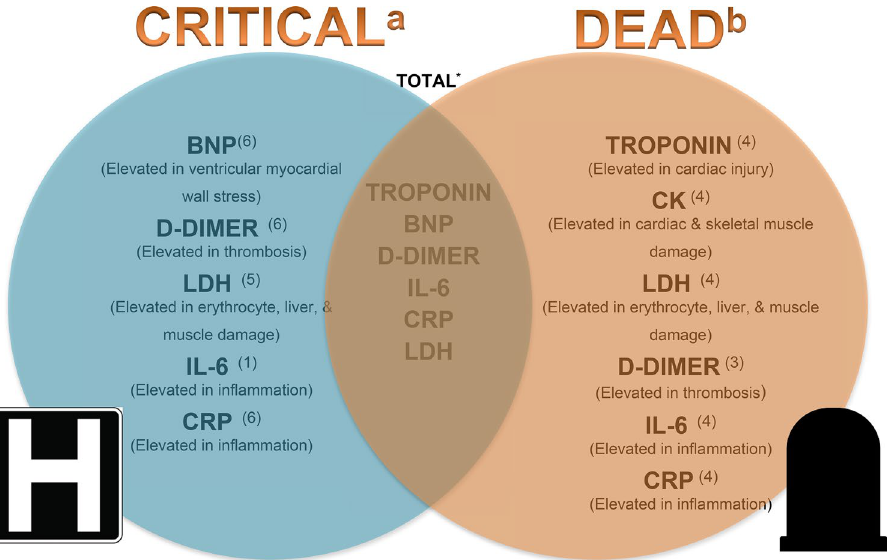
Figure 4. Biomarkers in COVID-19 patients. a Significant difference seen in biomarkers in COVID-19 patients who were critically ill. b Significant difference seen in biomarkers in COVID-19 patients who died. *Significant difference seen in biomarkers in COVID-19 patients who died and/or were critically ill . Superscripts: total number of articles in each group. Biomarkers studied: Troponin, BNP, CK, CRP, LDH, D-dimer,